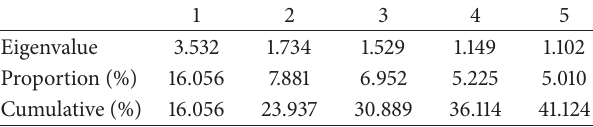
Table 1: The eigenvalue of correlation